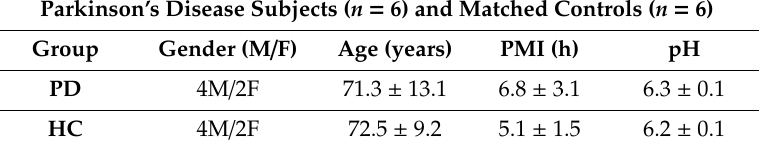
Table 1. Postmortem brain samples’